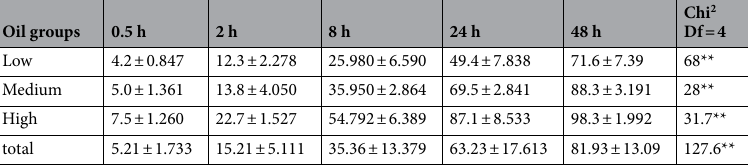
Table 5. Friedman test for larval mosquito mortality (%) of plant oil groups at 1000 ppm. **The X 2 value is sig. at significant level